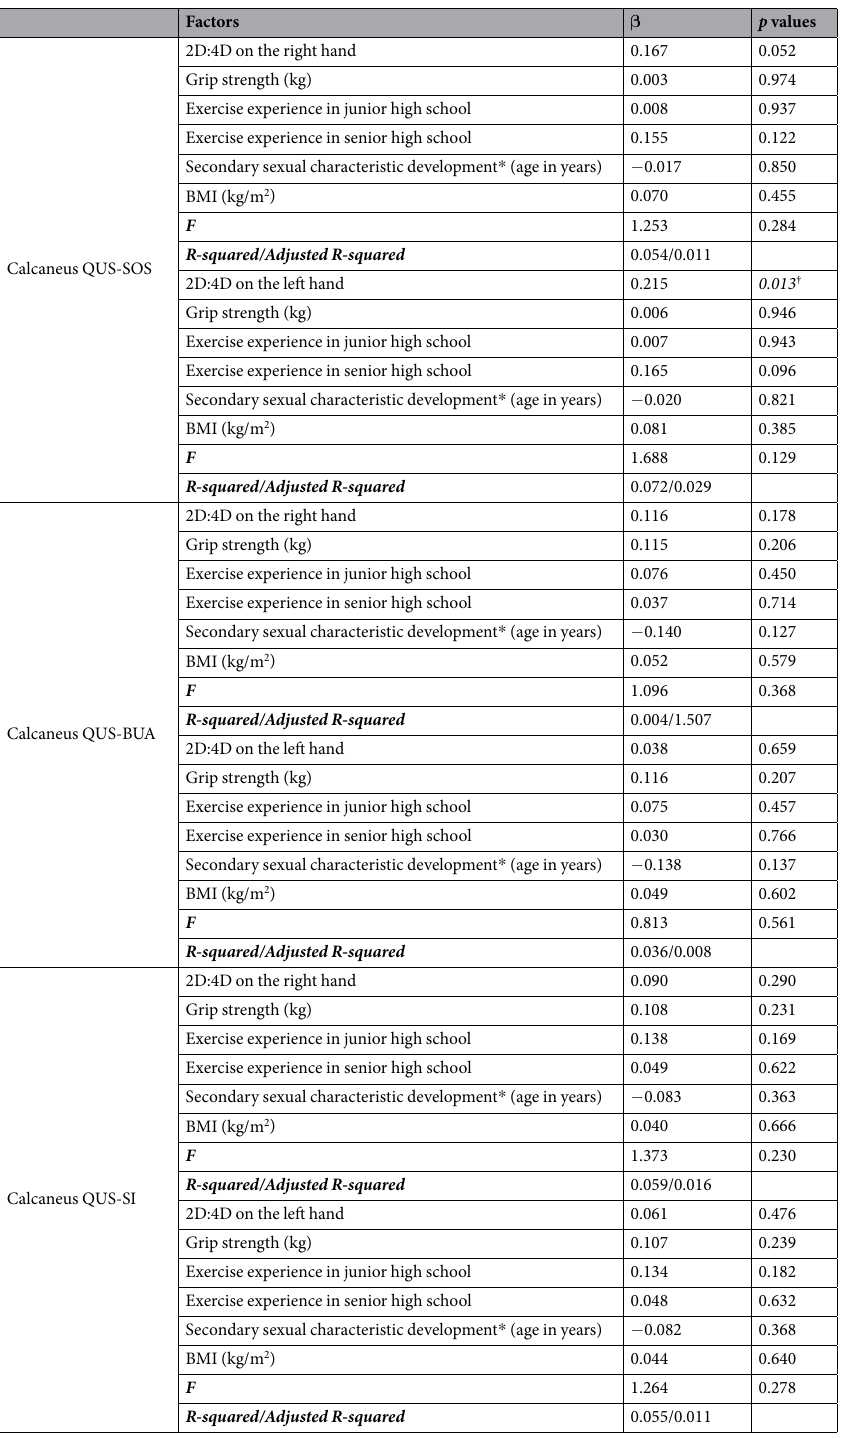
Table 3. The effect of the digit ratio (2D:4D) of both hands on the calcaneus QUS values by a multiple regression analysis, n = 138. 2D:4D, ratio of the finger length of the 2 nd and 4 th digit; BMI, body mass index; QUS-SI, stiffness index by quantitative ultrasound; QUS-SOS, speed of sound by quantitative ultrasound; QUS- BUA, broadband ultrasound attenuation by quantitative ultrasound. * The age at which menstruation started, † Indicates a significant correlation with calcaneus QUS-SOS. Adjusted for